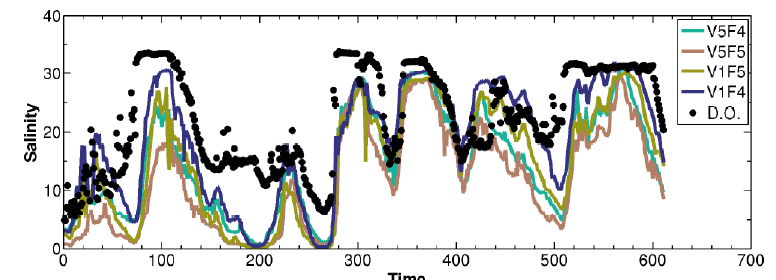
Figure 2. Comparison between observations (black dots) and model results (colored lines) for four parameters’ settings. The plot shows the meridional component of currents above and salinity below at Praticagem Station.